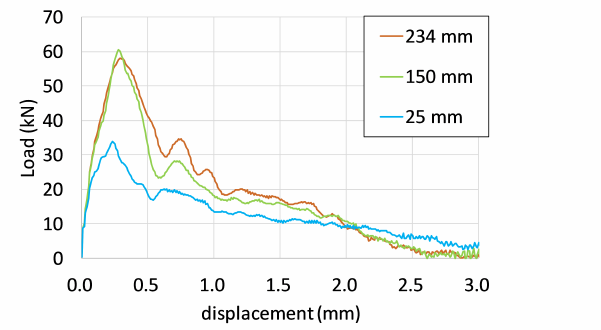
Figure 23. Load-displacement relationships with different spacing.